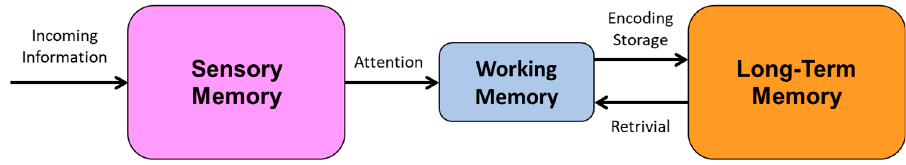
Figure 1. Sensory memory, working memory, and long-term memory.